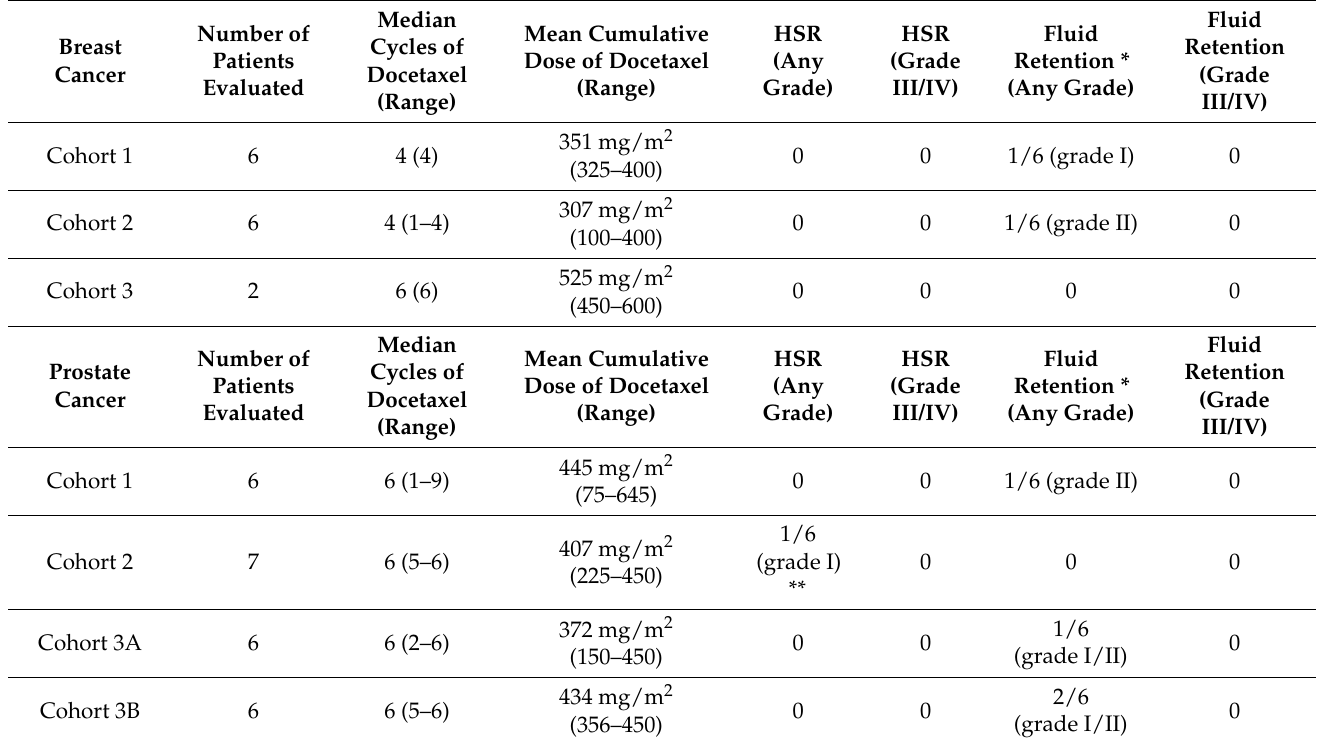
Table 3. The occurrence of hypersensitivity reactions (HSR) and fluid retention (More details can be seen in Table S4).